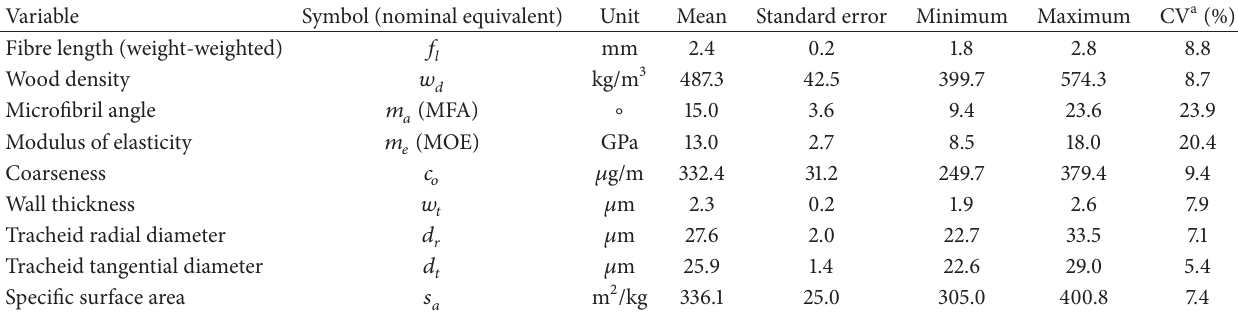
Table 3: Statistical summary of the area-weighted fibre attribute values derived from the 47 breast-height cross-sectional sample disks at the time of